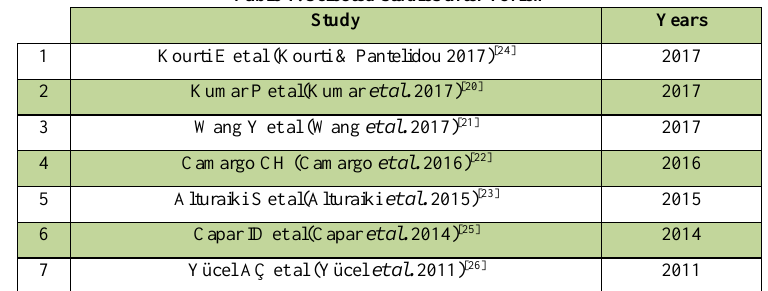
Table 1. Selected studies after review